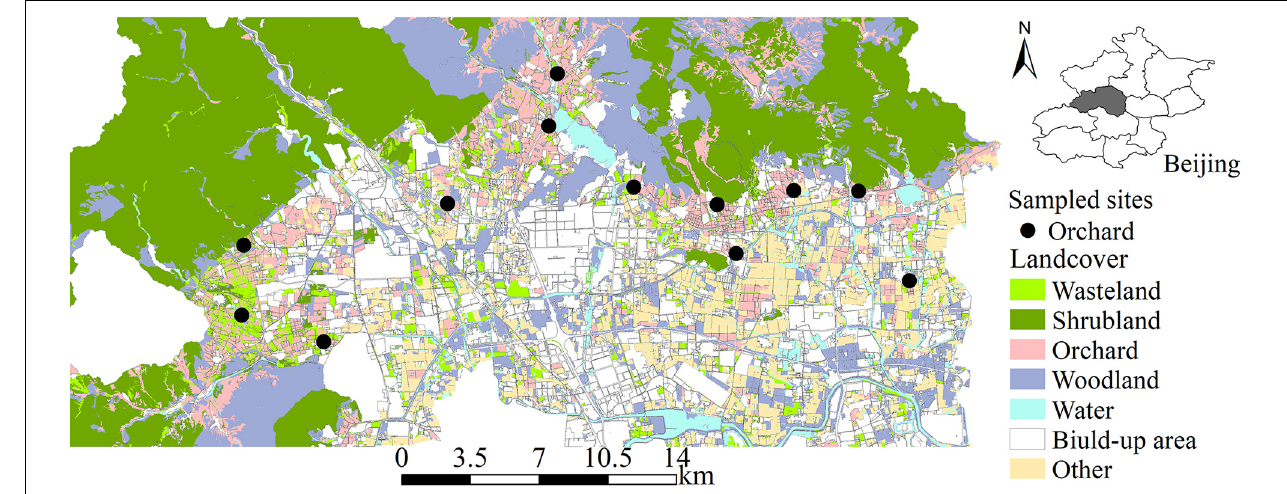
FIGURE 1 | The distribution of sampling